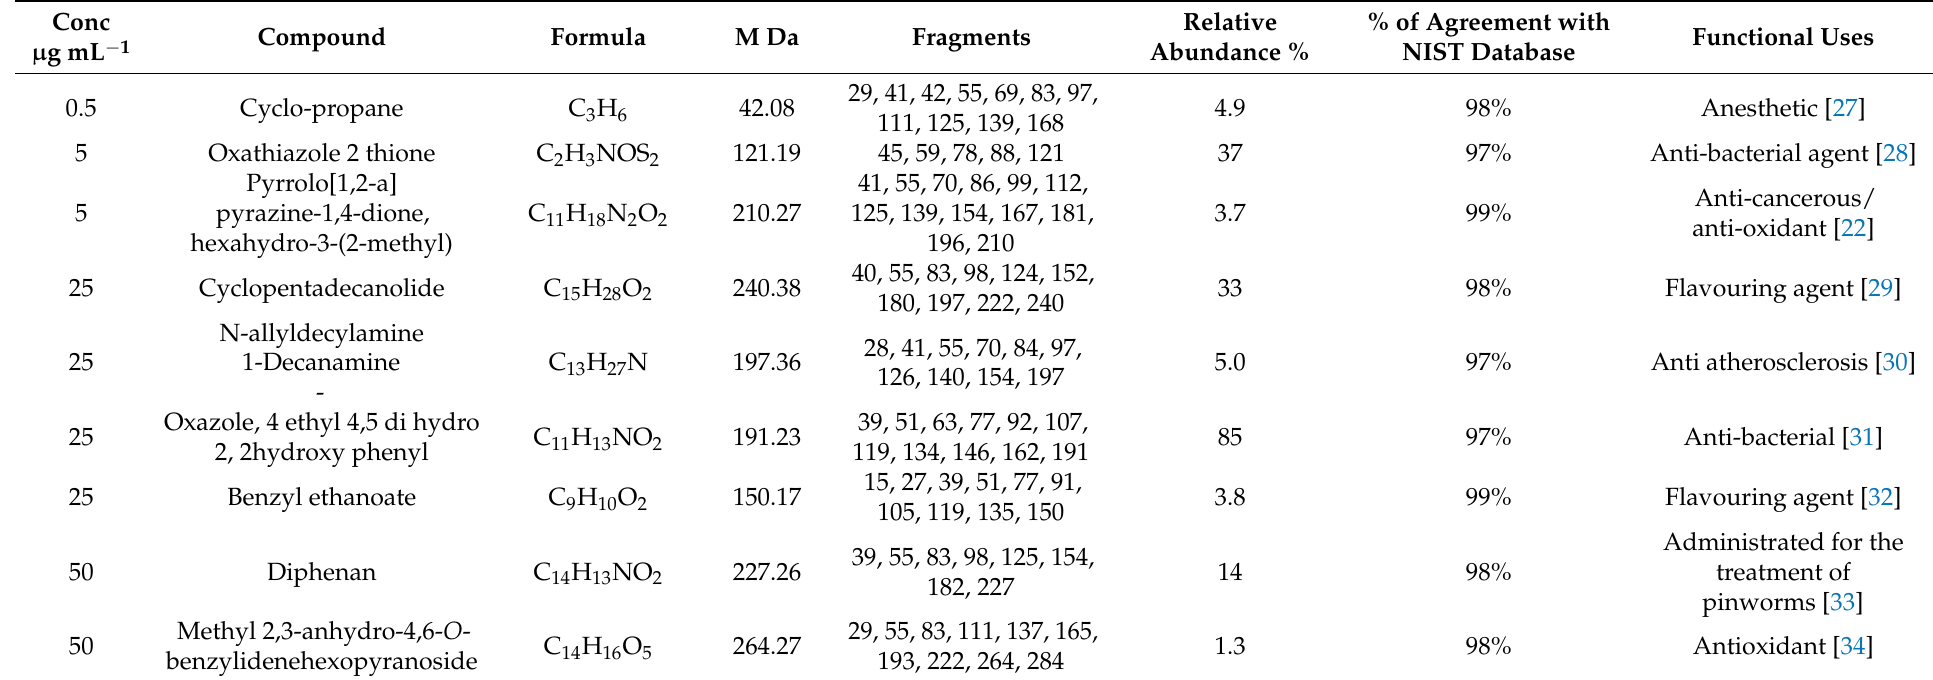
Table 2. Relative abundance, molecular mass, and fragments of the compounds present in the endophytic fungus P. heveicola extract cultured with the epigenetic modifier valproic acid in different concentrations ( µ g mL − 1 ) as identified using GCMS/MS